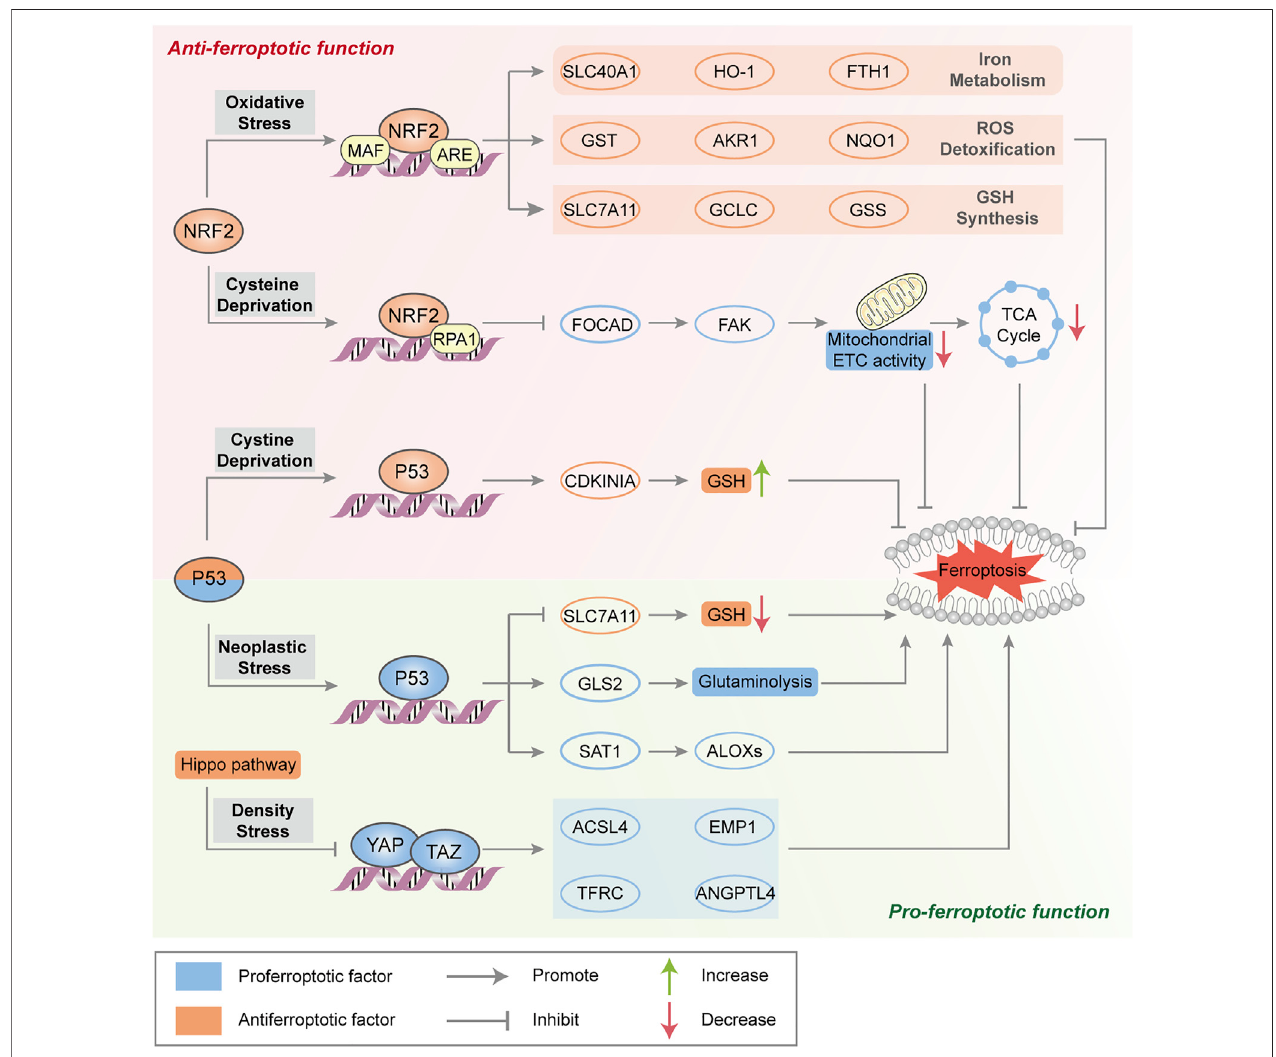
FIGURE 2 | Major transcription factors in the regulation of ferroptosis. NRF2 transactivates a range of cytoprotective genes under endogenous oxidative stress to driveantiferroptoticfunction. Moreover,NRF2 represses FOCADexpression and FAKactivity and furtherreduces sensitivity tocysteine deprivation-inducedferroptosis. Generally, p53 triggers ferroptosis to suppress tumorigenesis by transcriptional regulation of ferroptosis-related genes. In some circumstances, p53 suppresses metabolic stress-induced ferroptosis to preserve cell survival in certain cancer cells. The Hippo pathway negatively regulates a series of proferroptotic genes via YAP/TAZ transcription